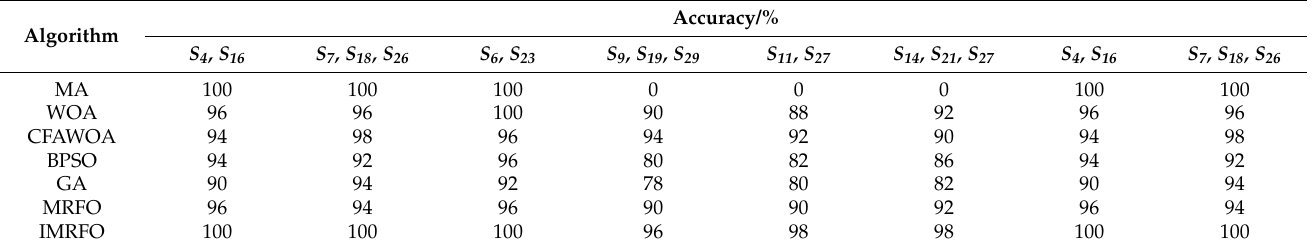
Table 10. Multiple fault location